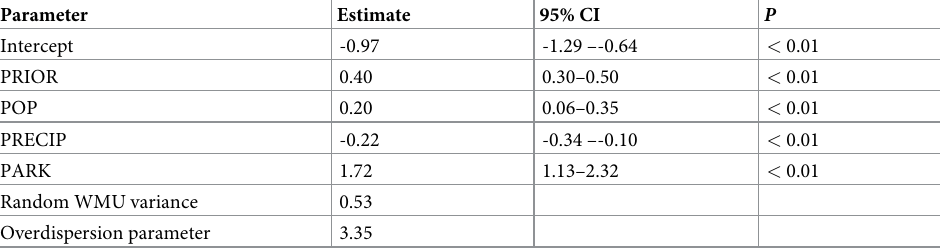
Table 2. Results from a top-ranked negative binomial regression model of high or moderate severity (Class 1–2) bear conflicts, New York, USA, July–September 2006–2019. Covariates included mild severity (Class 3) conflicts early in the year (April–June; PRIOR), bear abundance index as a metric of relative bear population size (POP), cumu- lative precipitation difference from mean early in the year (PRECIP), and whether the Wildlife Management Unit (WMU) was within a park (PARK). Continuous covariates were standardized before